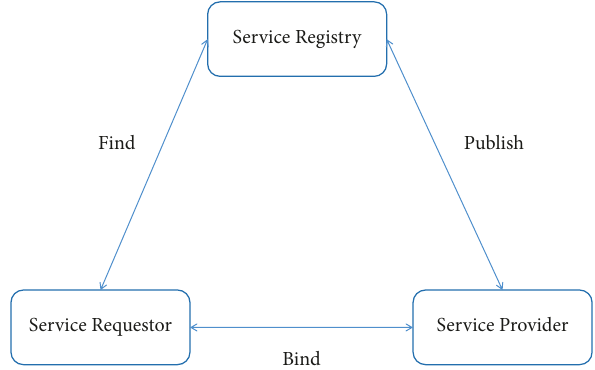
Figure 8: Tooth profile error and contact line error caused by hob installation